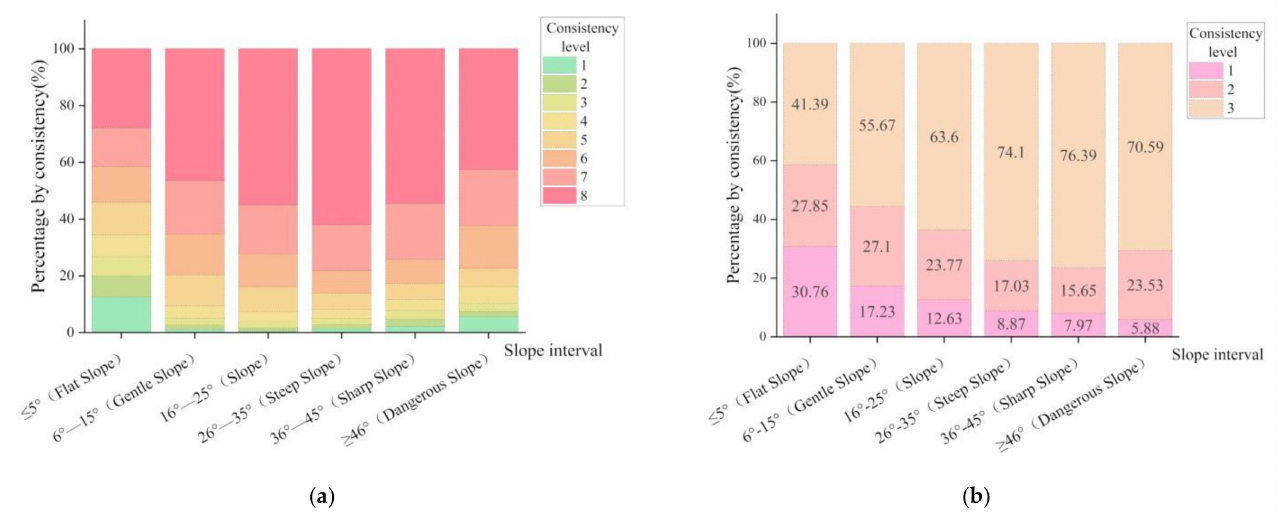
Figure 9. Consistency distribution among different slope intervals. ( a ) Eight datasets; ( b ) Three datasets in